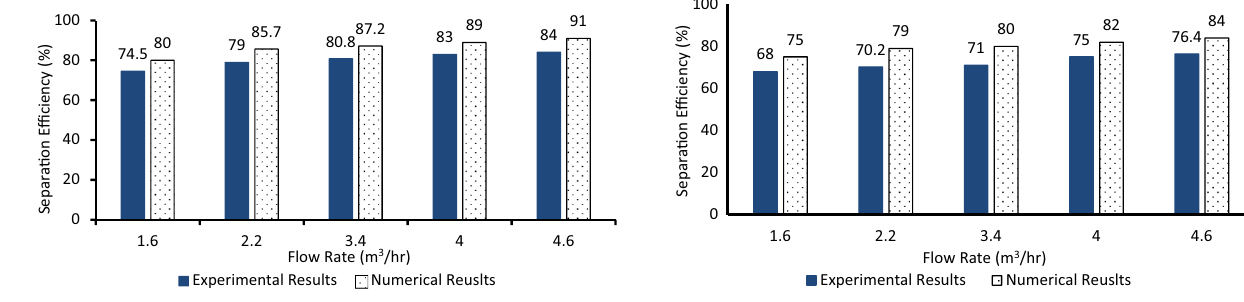
Fig. 7 Comparison between experimental measurements and CFD prediction of separation efficiency results of, 90:10 water-to-oil ratio at 80 °C, for different flow